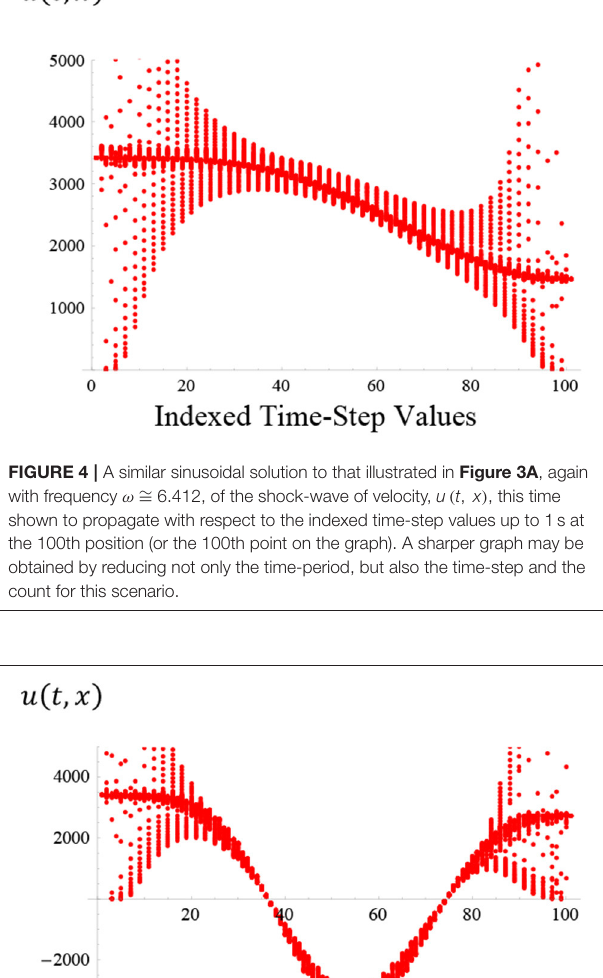
coordinate, x , also suppressed—is shown in the